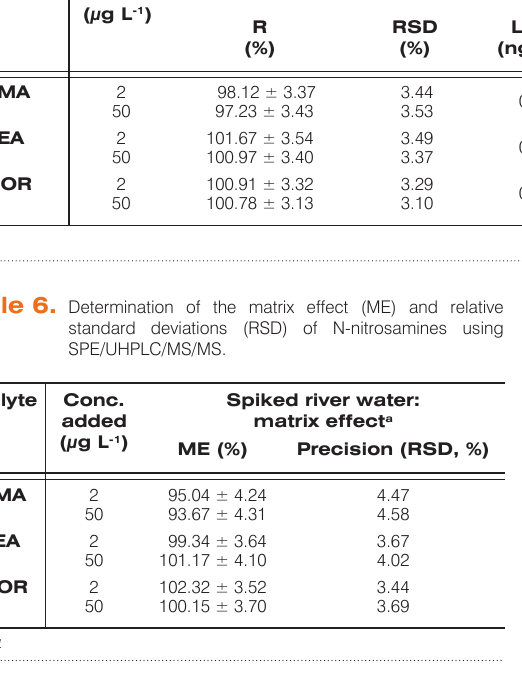
Table 5. Recoveries (R), relative standard deviations (RSD), and detection limits (LOD) of various N-nitrosamines using SPE step. Analyte Conc. added